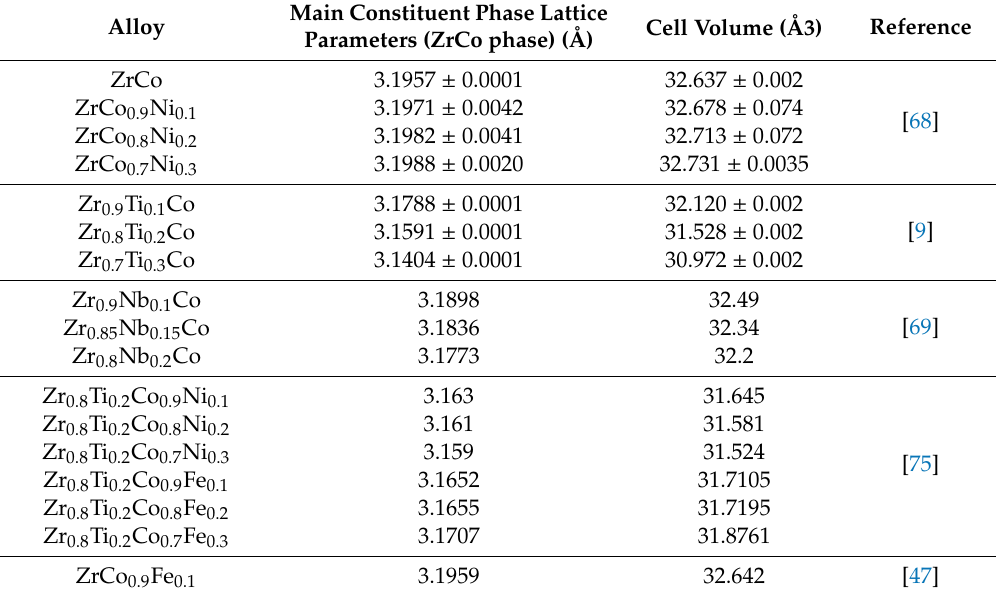
Table 1. Lattice parameters and cell volumes of ZrCo-based alloys measured by XRD.